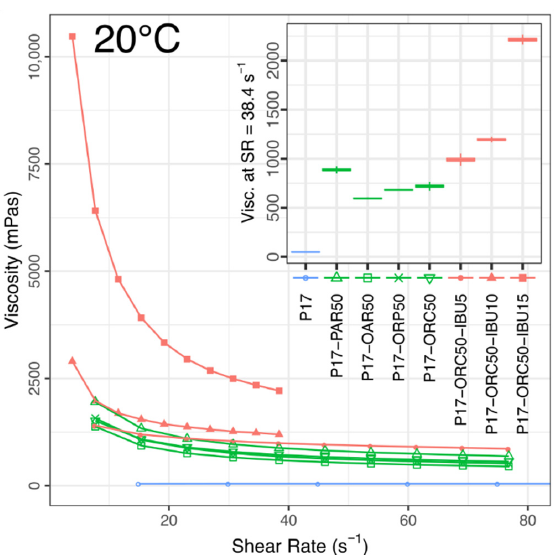
Figure 5. Viscosities vs. shear rate in blank and drug-loaded emulsions compared to the P17 solution. 20 °C, mean values, n = 3. Inset shows mean viscosities at SR = 38.4 s − 1 (±std error, ±95% conf. interval). Different shear rate ranges were dictated by the rheometer’s capabilities. Table 3. Summary of rheological data. Means ± sd, n = 3. Viscosities (v) in mPas; Pseudoplasticity Index (PI)—dimension- less. Formulation